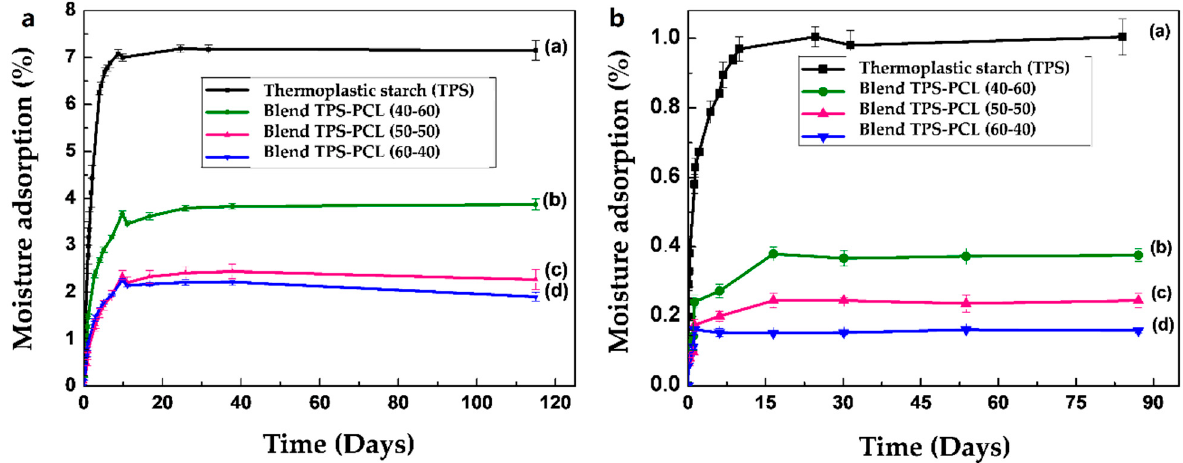
Figure 5. Moisture absorption of TPS, TPS/PCL 60/40 binary blend, TPS/PCL 50/50 binary blend, and TPS/PCL 40/60 binary blend, conditioned at ( a ) 54% and ( b ) 29% relative humidity.